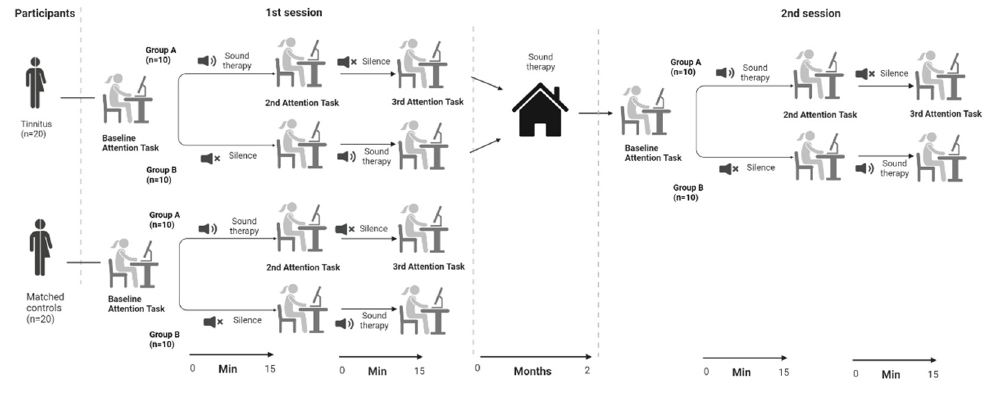
Figure 3. Overview of the study. Created with [28].